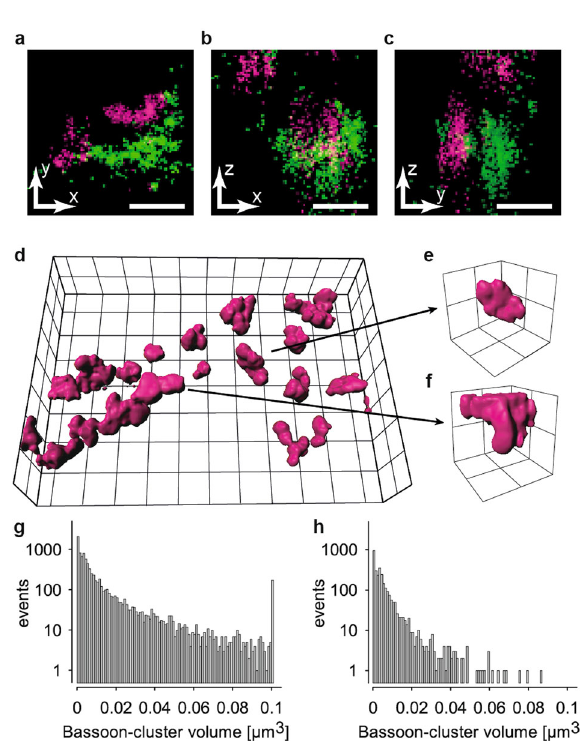
Fig. 3 3D imaging uncovered truncation of Bassoon clusters. a – c Representative two-color 3D d STORM images of synaptic contacts with presynaptic Bassoon (green) and postsynaptic Homer 1 (magenta) in all three orientations ( xy -view, xz -view, and yz -view; see Suppl. Video 1. d Volume reconstruction of a dataset of Bassoon. An entire cluster ( e ) within the imaged tissue volume, and a truncated cluster ( f ) extending beyond its upper edge are shown. Semi-logarithmic histograms of cluster volumes in seven images from 1 animal for all clusters ( g , n = 8956) and for selected non-truncated clusters ( h , n = 2925). Scale bars in a – c 100 nm, grid size in d 2 µ m and in e , f 500